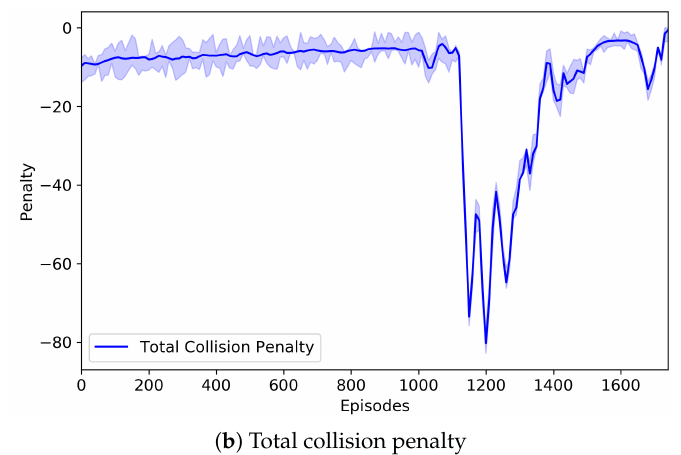
Figure 6. The change of the number of parcel collisions and the change of the total collision penalty imposed on the emission agents. We conducted seven experimental runs. The graphs show the average, the maximum, and the minimum of the two measures like Figure 5.